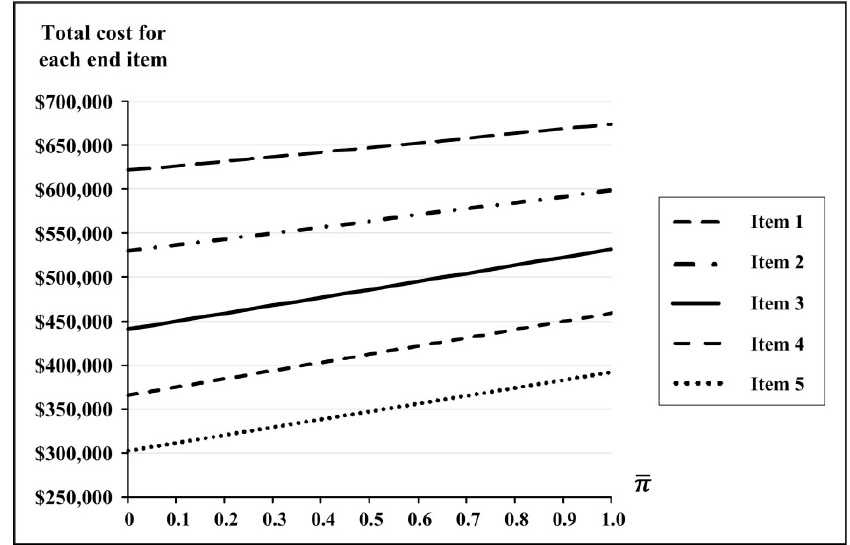
Figure 9. Effect of variations in 𝜋(cid:3364) on each item’s total cost. Figure 9. E ff ect of variations in π on each item’s total